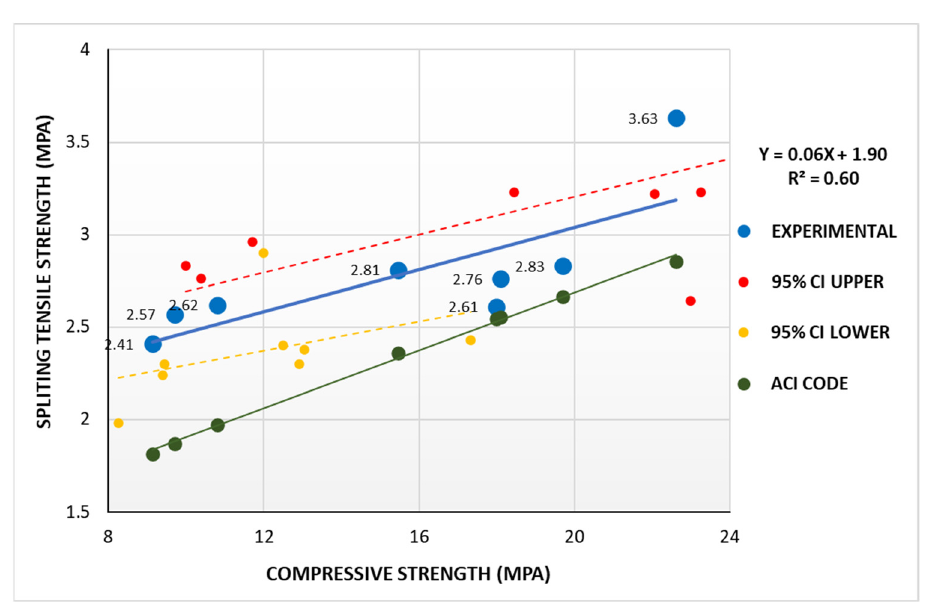
Figure 19. Relation between compressive and splitting tensile strength.